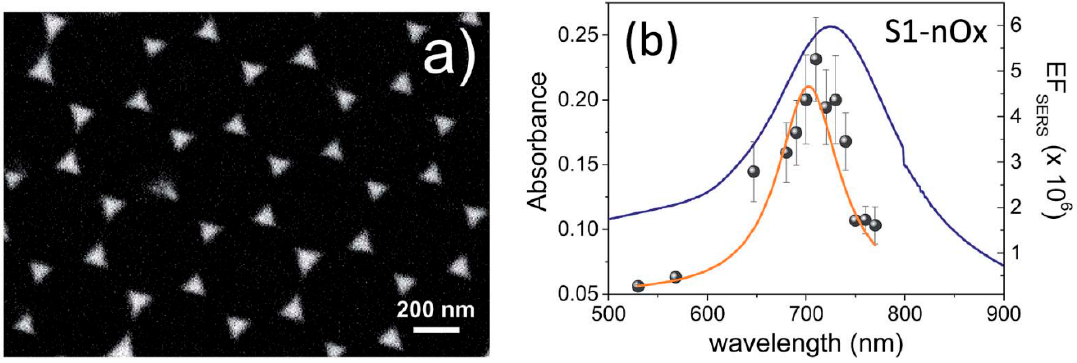
Figure 18. ( a ) SEM image of the SERS substrate fabricated by nanosphere lithography; ( b ) Extinction (blue line) and local field (dots and corresponding fit) distribution. Reproduced with permission from